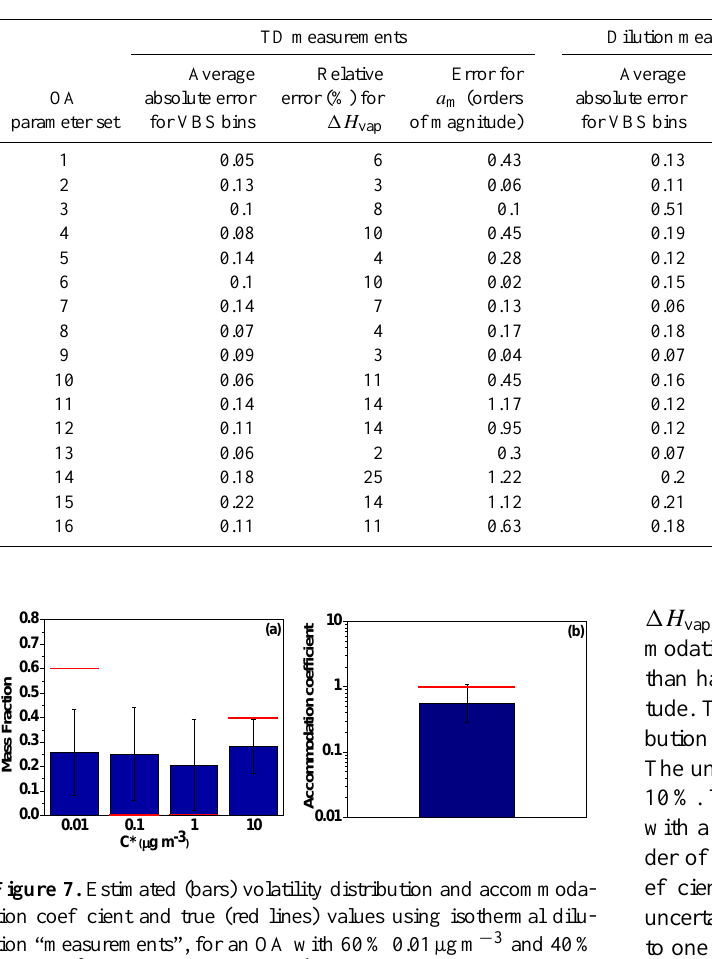
Table 3. Results for the sets of random volatility distributions using different inversion approaches.